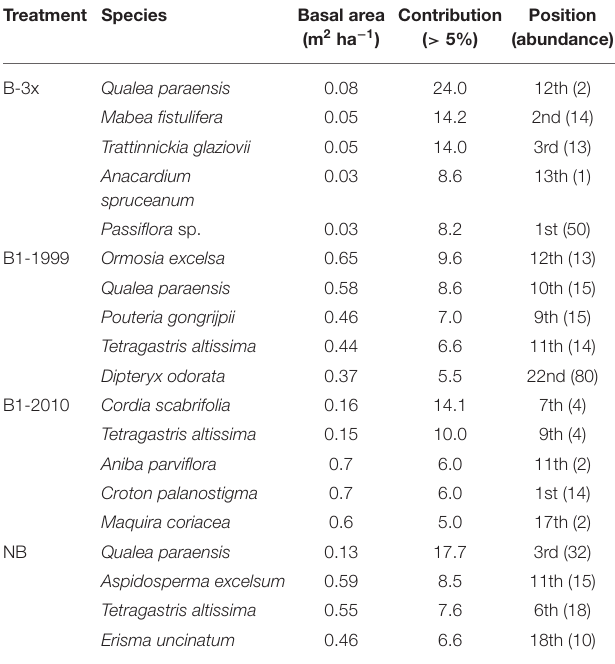
TABLE 4 | Species that contributed most to basal area (m 2 ha − 1 ) in each treatment and associated abundance. Treatment